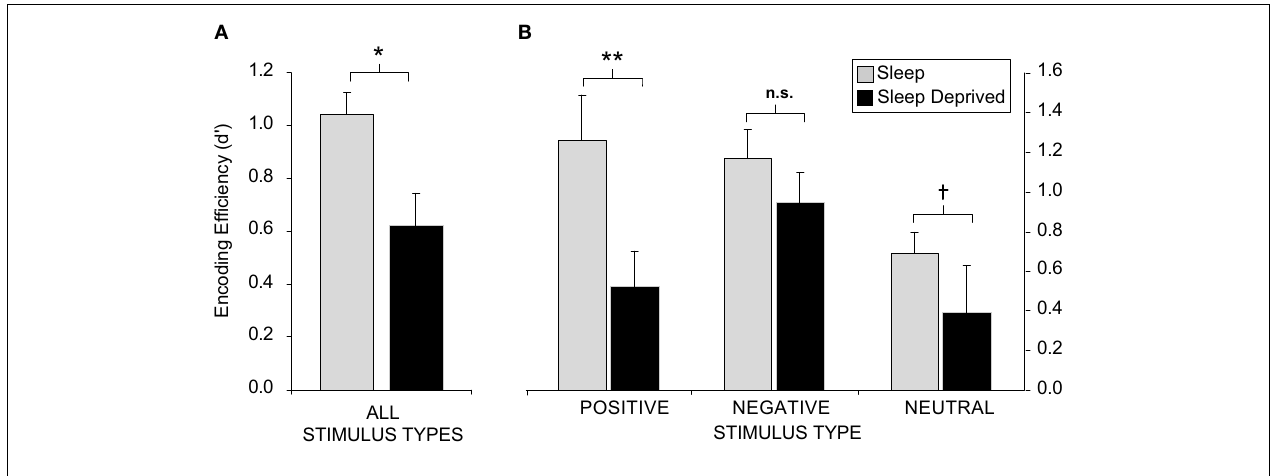
(neutral valance) categories.When comparing between positive and negative words, within group, no significant difference was found for the sleep group while those that were deprived demonstrated greater recall for negative items ( p < 0.05). † p < 0.08, * p < 0.05, ** p < 0.01, error bars represent S.E.M.